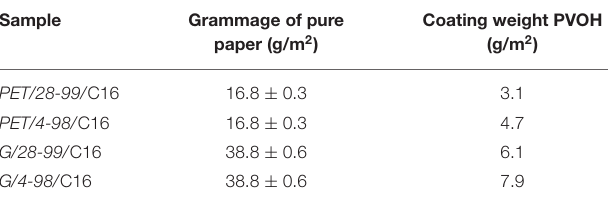
TABLE 2 | Results of surface weight measurement for PVOH coated